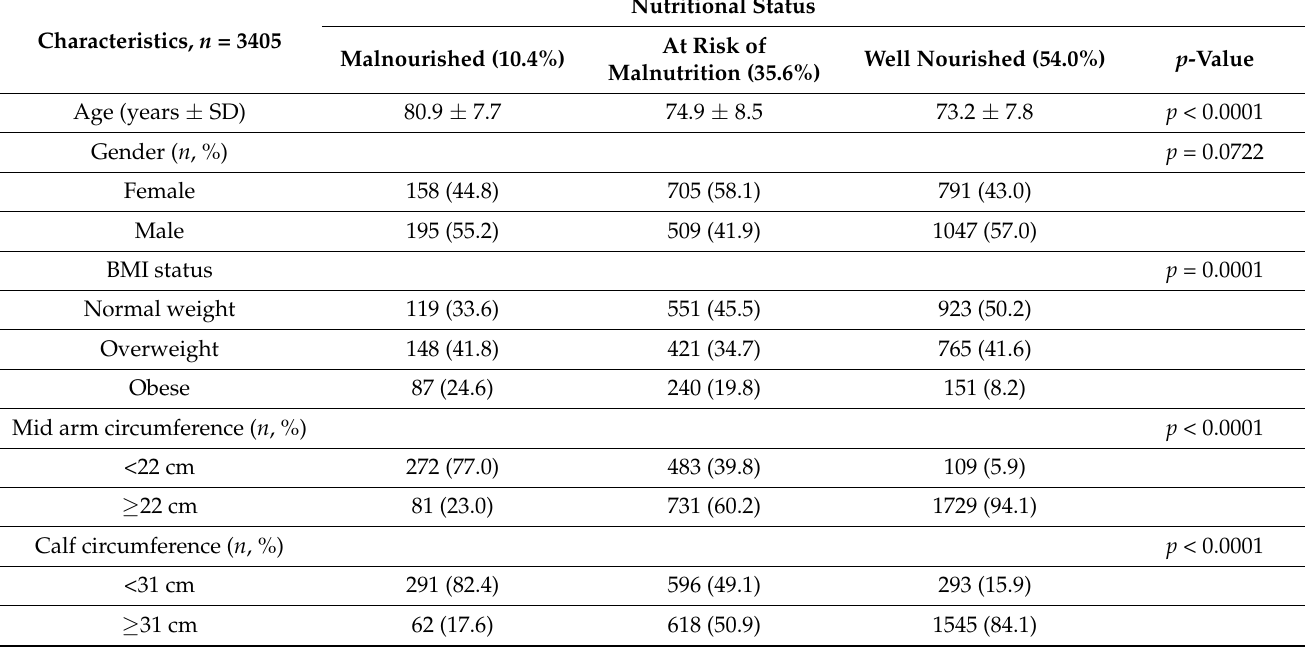
Table 2. Comparisons between nutritional status and participants’ sociodemographic characteristics, anthropometric measures, HRQOL, IPAQ and PSQI